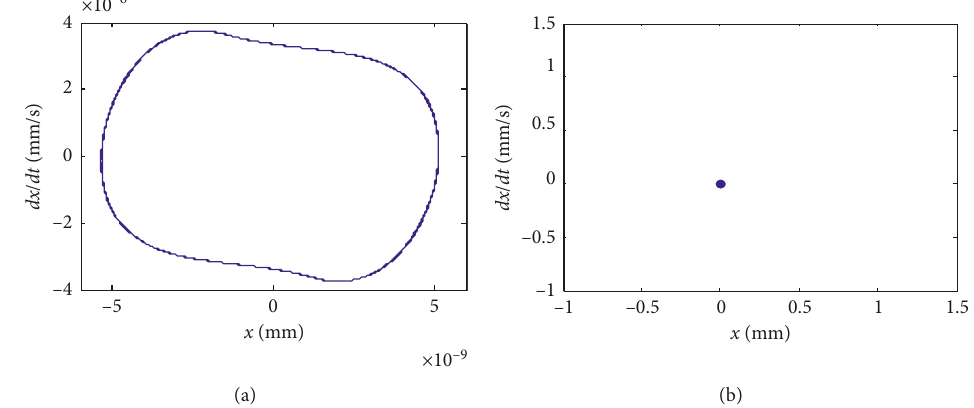
Figure 7: System response for ω � 3000r/min. (a) Phase portraits. (b) Poincar´e